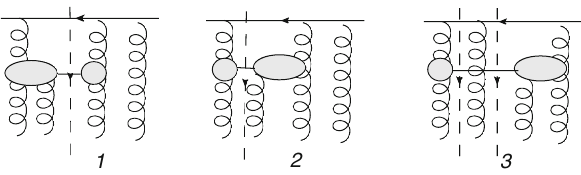
2 31 Fig. 5 Typical cut amplitudes with vertex (cid:2) R → RRG and rescattering